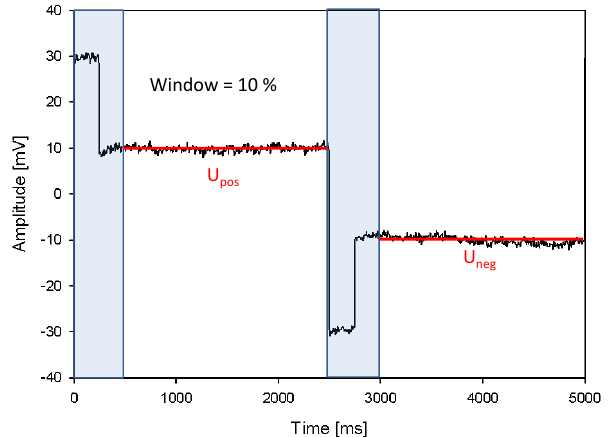
Figure 8. Drift-corrected signal U dr (t ) and mask signal M(t) in correct